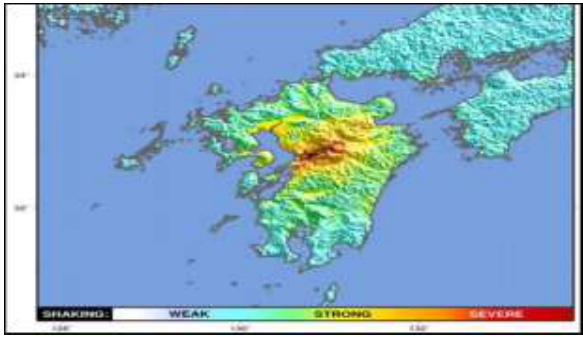
Figure 9 Kumamoto Earthquake ShakeMap (April 15, 2016) ( https://www.usgs.gov) .